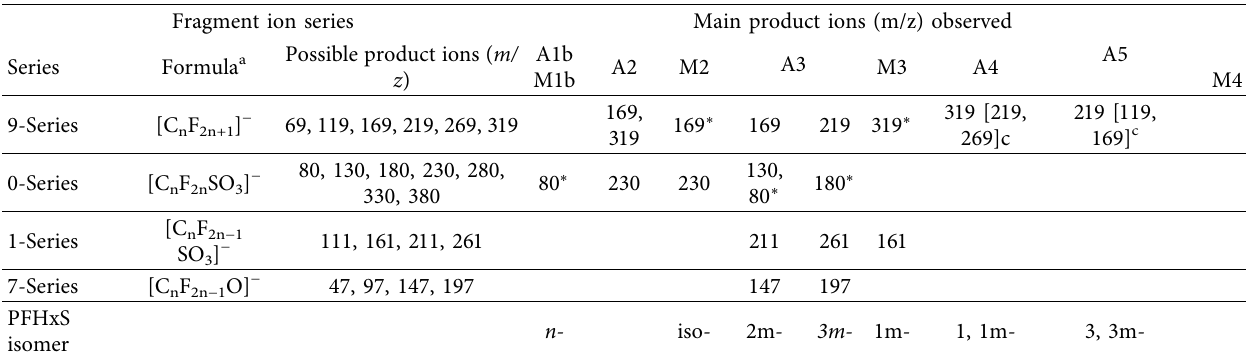
Table 2: Identification of PFHxS isomers based on the observed specific series of product ions produced from the molecular anion m/z 399. Fragment ion series